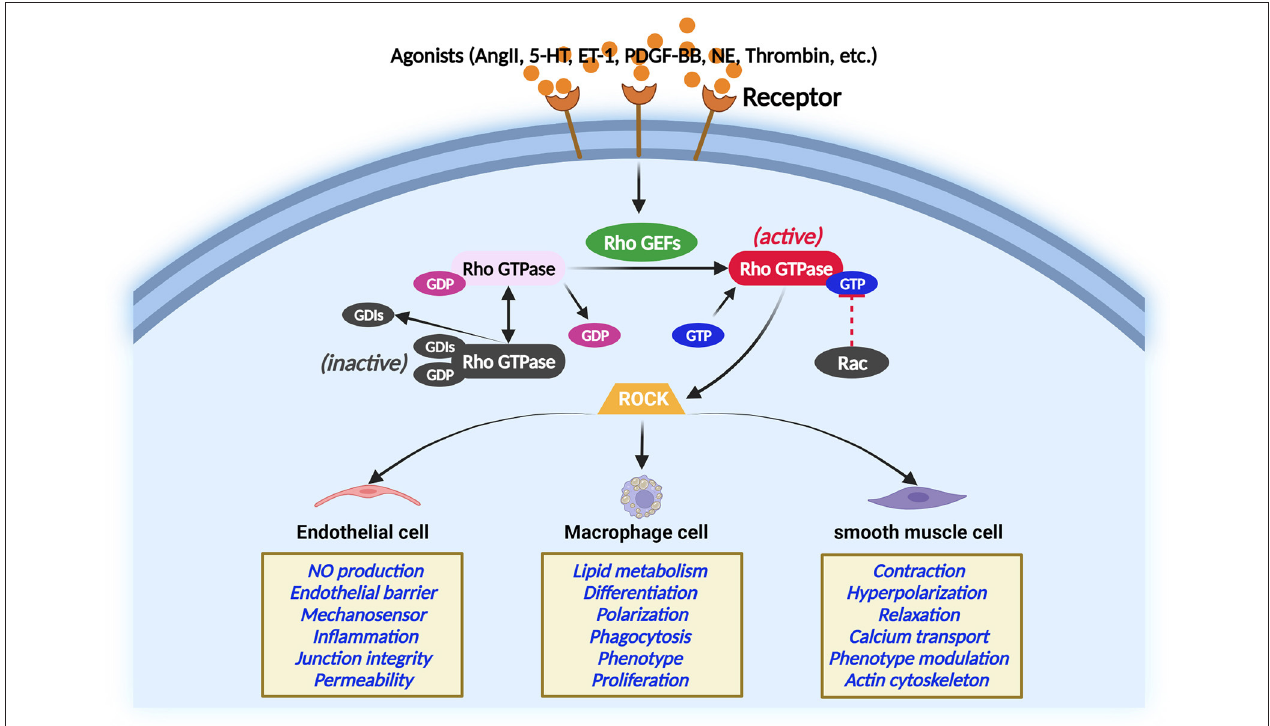
FIGURE 2 | Regulation of Rho GTPase in different main atherosclerosis-related cells. Rho GTPase acts as a molecular switch that cycles between an inactive and active GTP-bound conformation interacting with ROCK. The activity of Rho GTPases is controlled by Rho GEFs that catalyze the exchange of GDP for GTP. In contrast, GTPase-activating proteins stimulate the intrinsic GTPase activity and inactivate Rho GTPase. Guanine nucleotide dissociation inhibitors block spontaneous Rho GTPase activation. The Rho GTPase/ROCK pathway plays important role in the main atherosclerosis-related cellular functions.